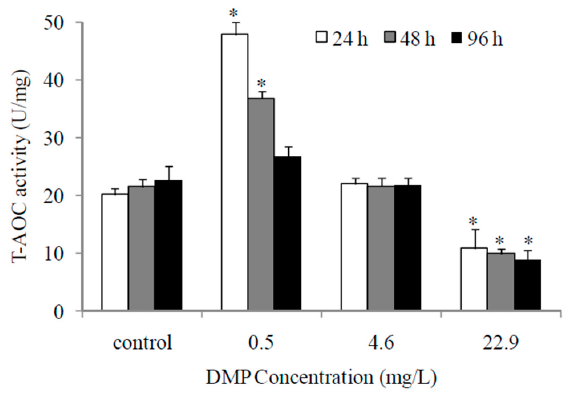
Figure 3. DMP-induced changes of total anti-occident capacity (T-AOC) in zebrafish. Adult fish were exposed to 0.5, 4.6 and 22.9 mg / L DMP for 24, 48, and 96 h. Statistical significance between experimental and control groups are indicated with asterisks: significance is based on Student’s t -test ( p < 0.05). The error bars represent the standard deviation (n = 5).